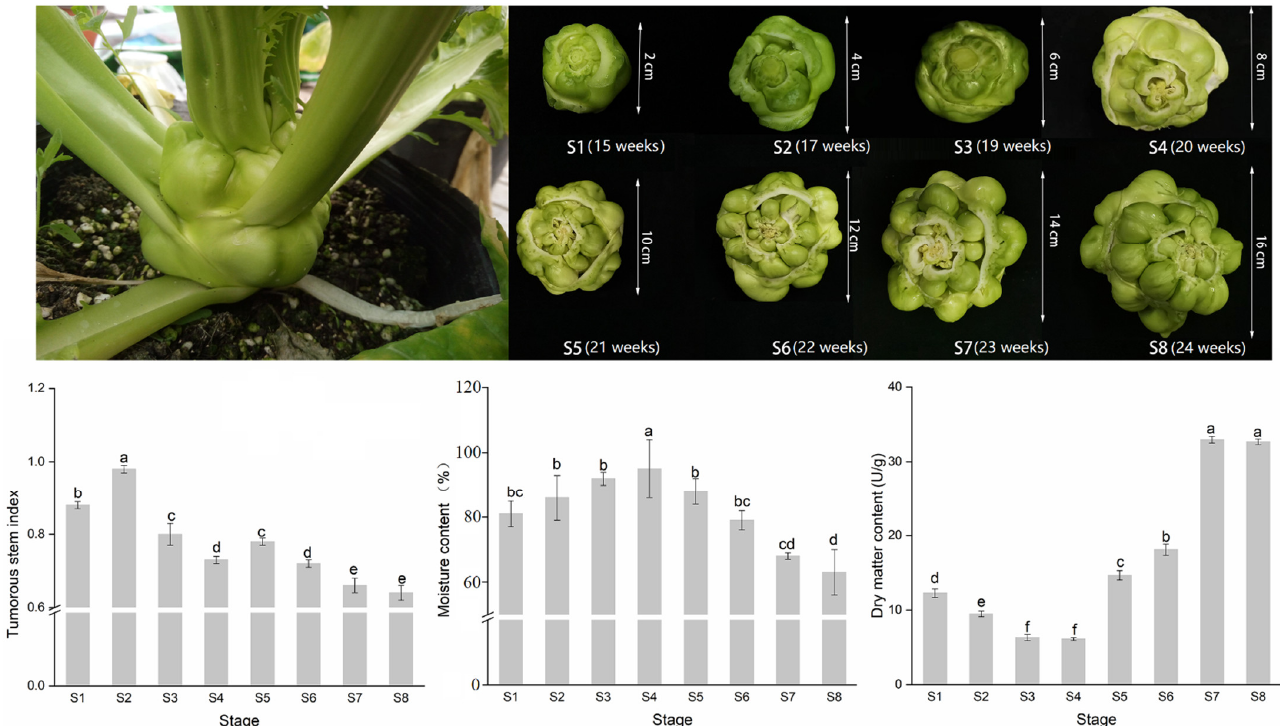
Figure 1. Changes in growth indexes of stem mustard at different developmental stages. Vertical bars with different letters (a–f) indicate significant differences at the 0.05 level. Three biological replicates were performed for each index.